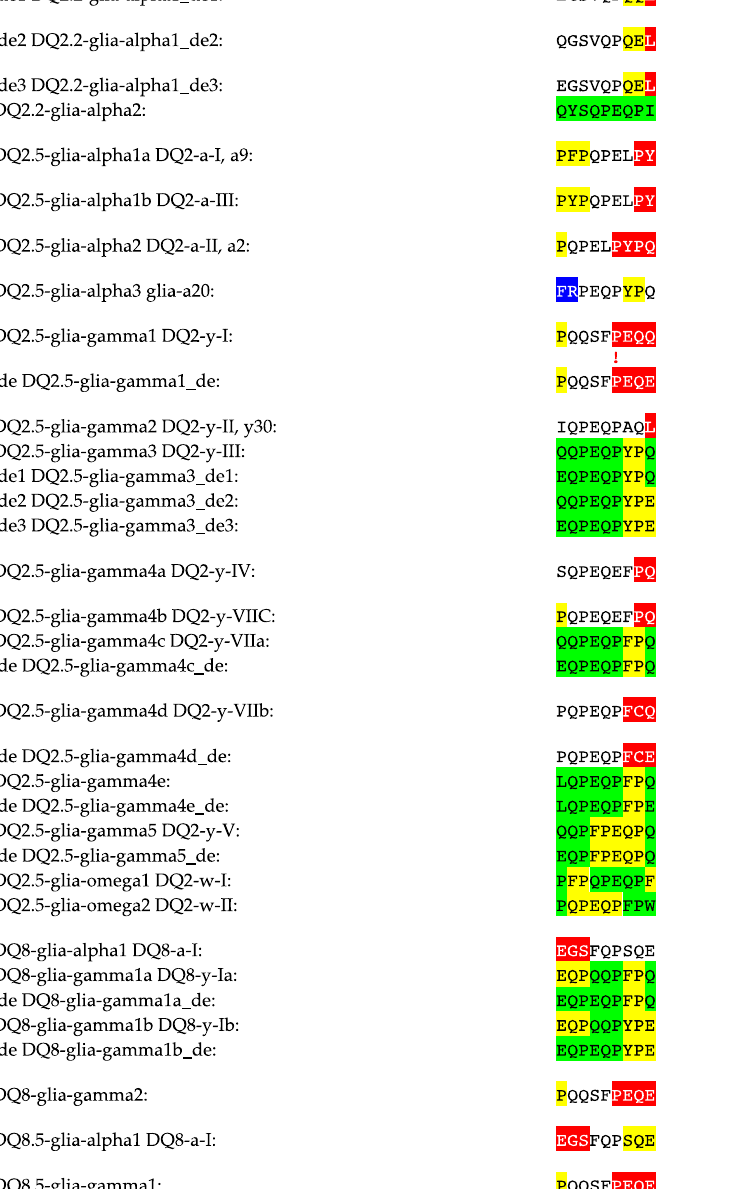
Figure 12. List of immunodominant peptides from α - and γ -gliadins, showing the peptide fragments excised by pepsin (highlighted red), trypsin (highlighted blue) and prolyl-endopeptidase (highlighted yellow). Peptides uncleaved by pepsin or trypsin are highlighted in green.